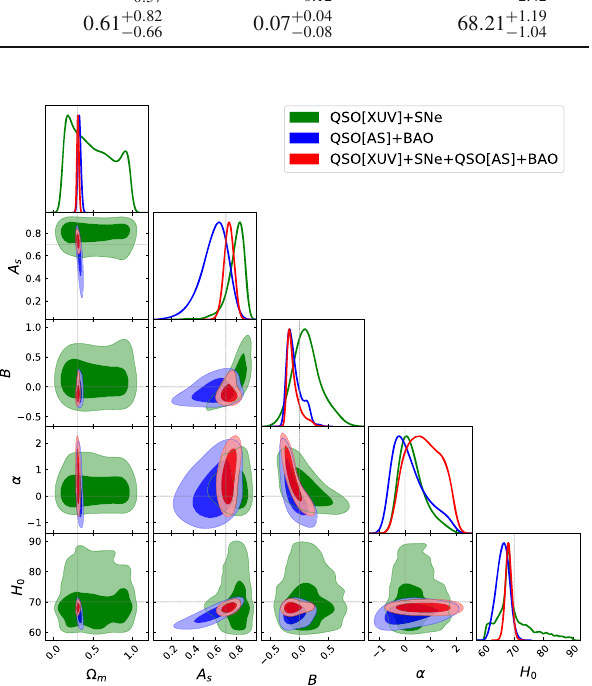
α = 0 . 046 + 0 . 107 = 0 . 0026 ± 0 . 005 at the 1 σ confi- − 0 . 102 and B dence level. This proves that most cosmological probes favor the Λ CDM model; however, the inclusion of the QSO sam- ple from X-ray and UV flux measurements [26] at higher redshifts changes to slightly favor the CG